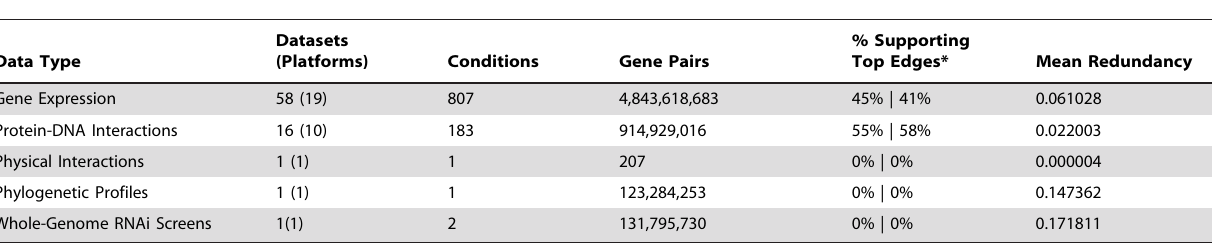
Table 1. Summary of Integrated mESC Genomic